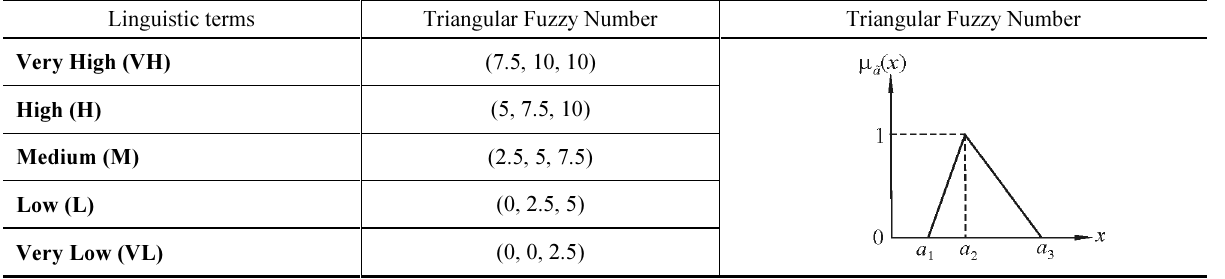
Table 1. Linguistic terms, fuzzy numbers and schema of triangular fuzzy numbers Linguistic